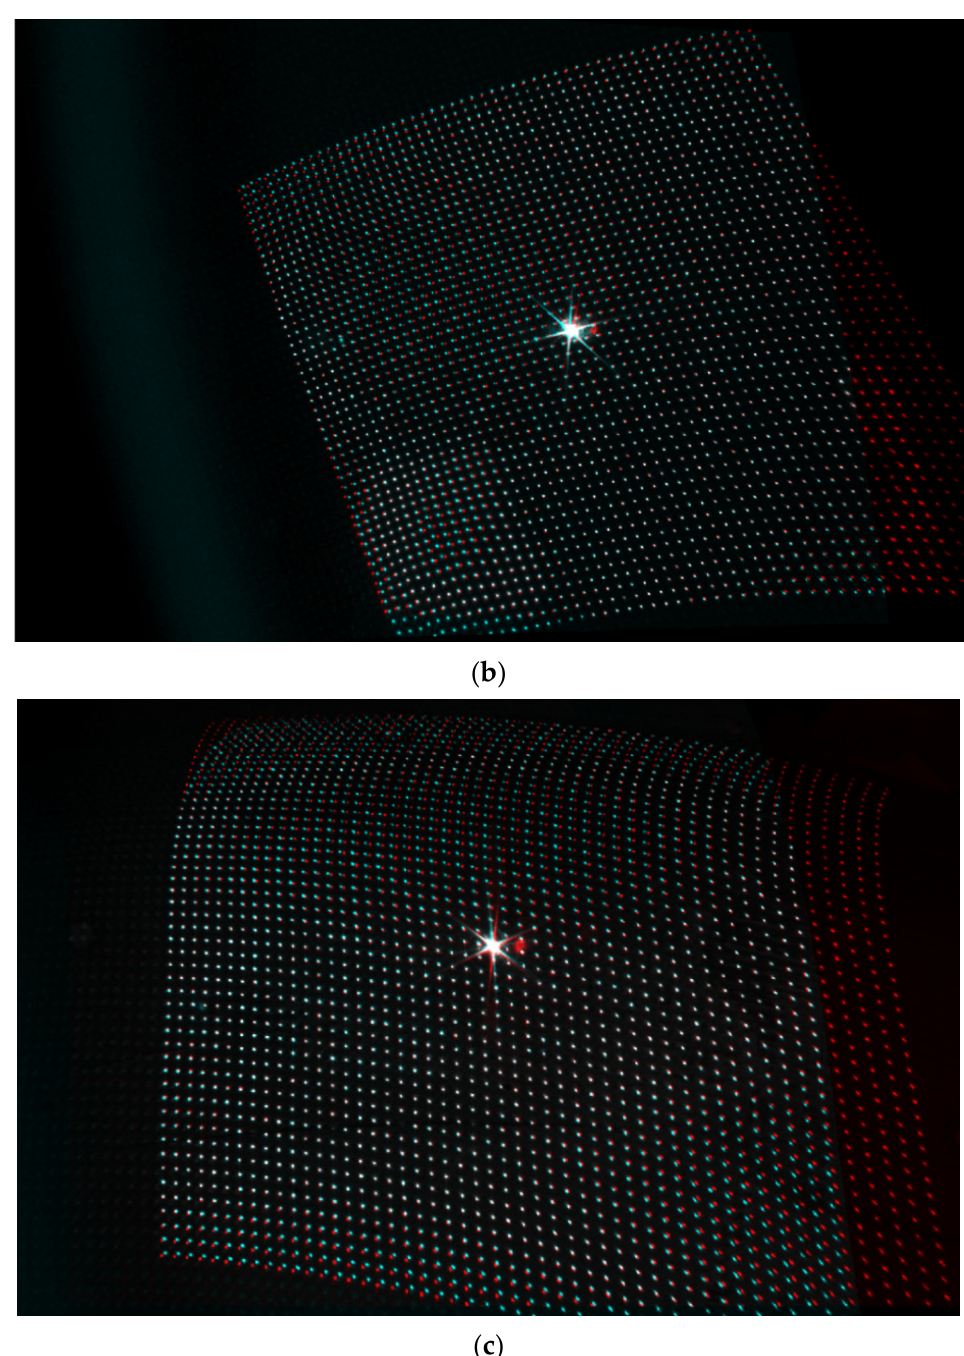
Figure 15. Anaglyphs created by overlaying the right-sided image after transformation onto the left one as a result of selecting a set of 10 matching points (variant W1) rotated to the right. Images of the marker grid: ( a ) Small deformation; ( b ) medium deformation; ( c ) large